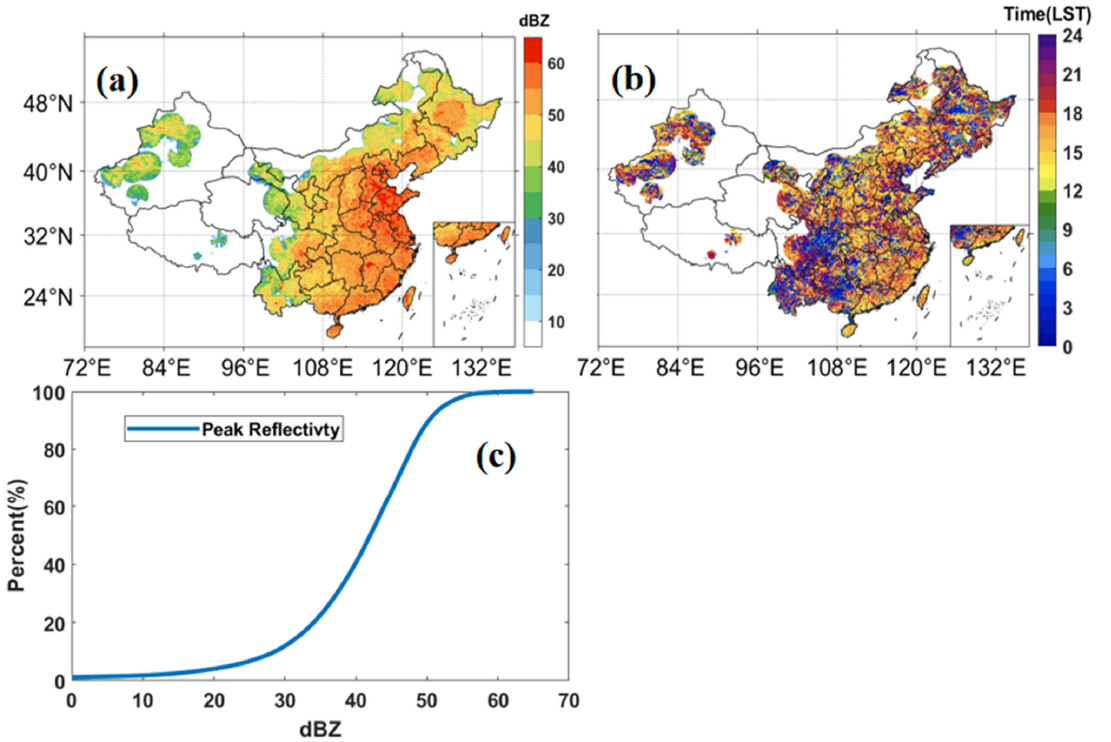
Figure 4. ( a ) Peak reflectivity (PR) and ( b ) the timing of peaks in reflectivity (PRT) over China during summer. ( c ) Cumulative probability distribution of the peak